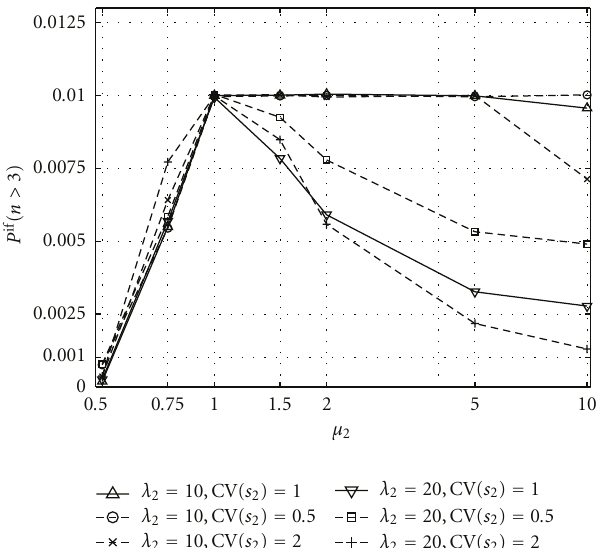
Figure 12: Interference ( P if ( n > 3)) with μ 2 and CV[ s 2 ] in S5a.